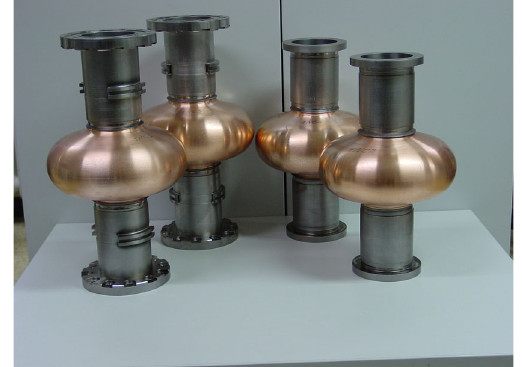
FIG. 37. NbCu clad cavities from explosive bonded tubes welded for preparation at DESY and JLab.